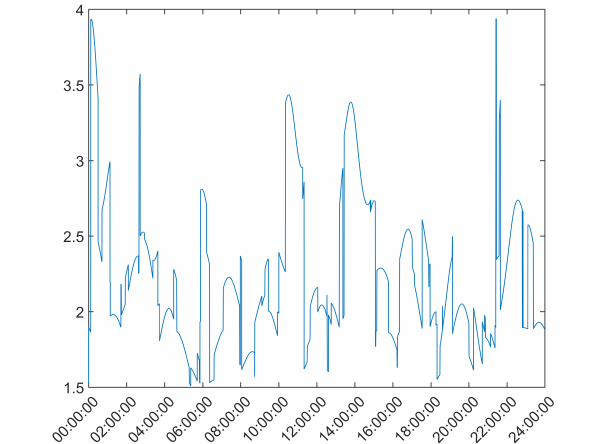
Figure 5. GDOP values for the 24 h survey of the base station